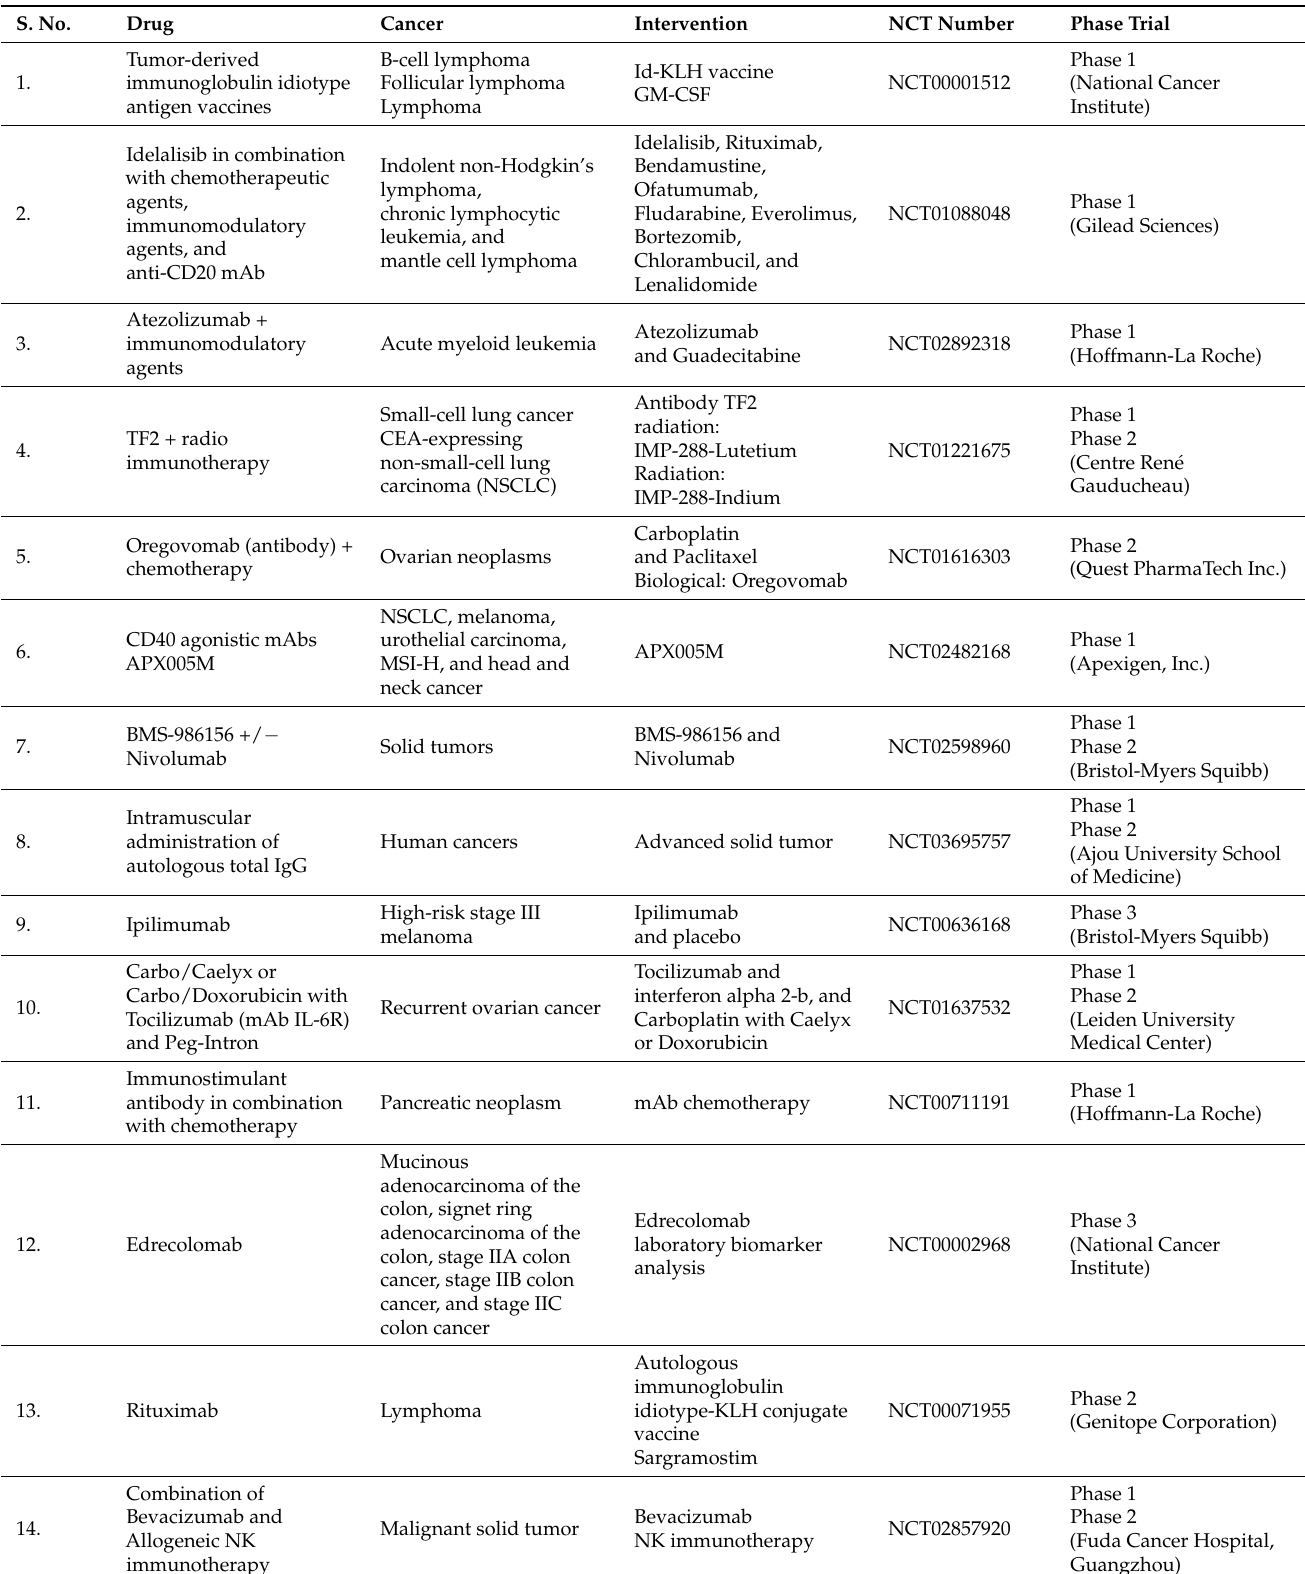
Table 1. Detailed description of clinical trials completed on the role of immunoglobulin in